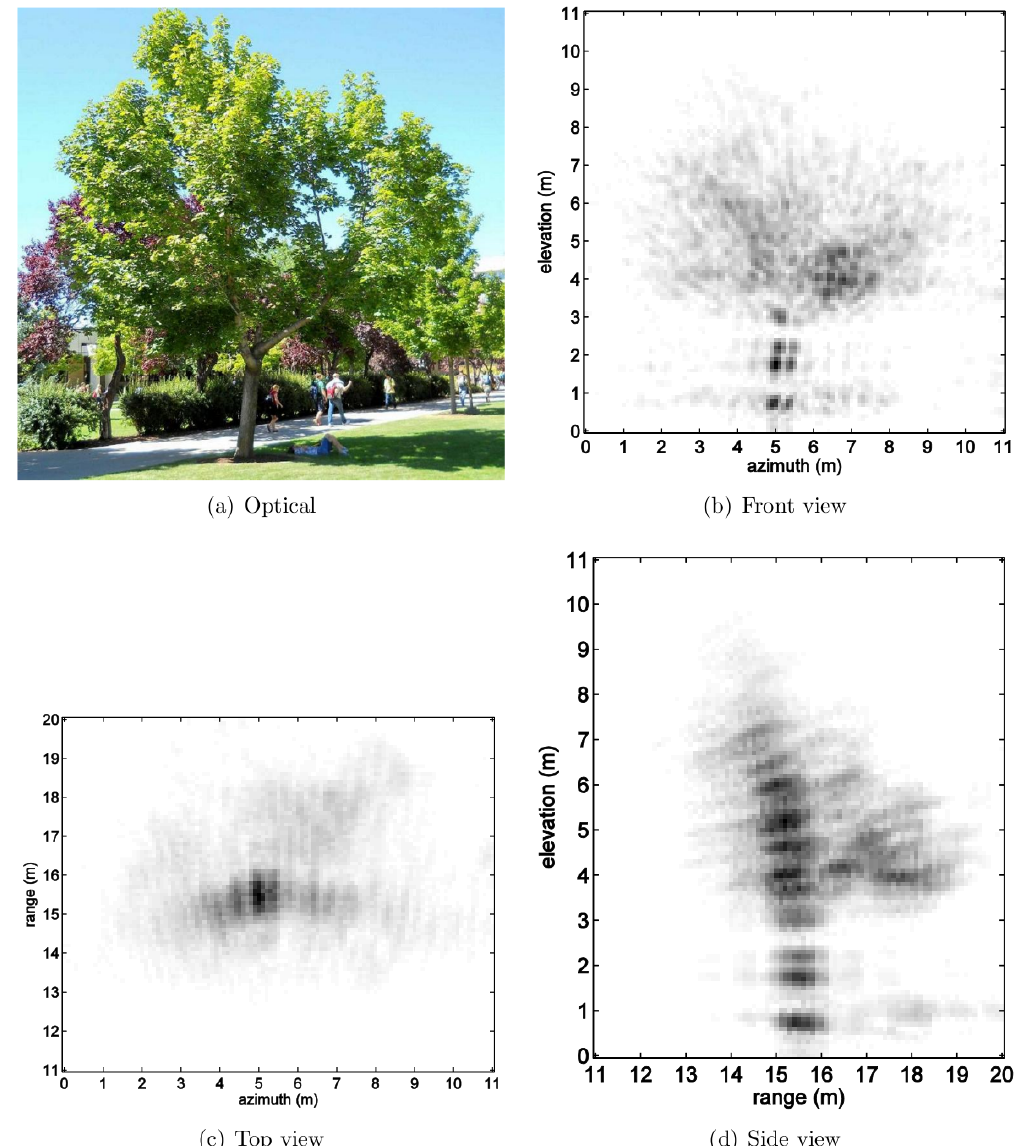
Figure 9. Optical and radar slices through 3D backscattering image of another Norway Maple tree. ( a ) optical image; ( b ) front view backscatter image; ( c ) top view image; ( d ) side view image. Multipath from the ground between the radar and tree distorts the image of the trunk. Note that the nearby light pole and trees in the background are excluded from the 3D imaging volume. The linear grayscale is arbitrary.